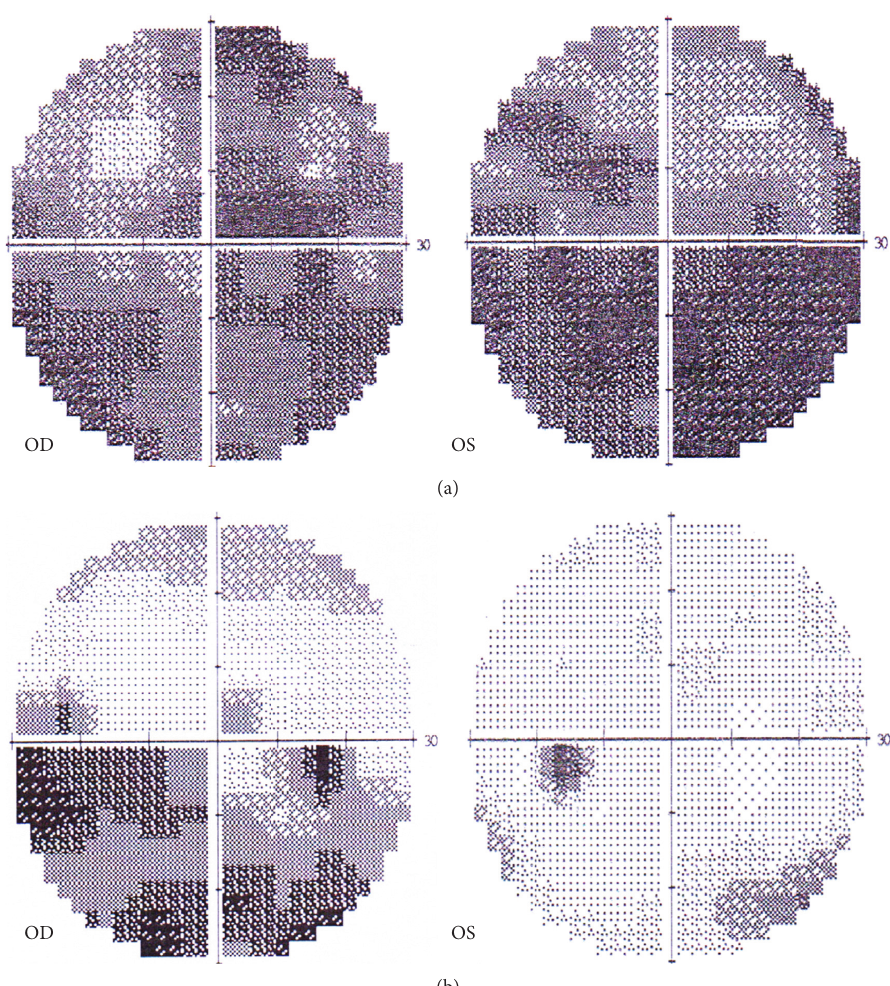
Figure 2: Grayscale showed visual field defect before and after orbital decompression on the left eye combined with methylprednisolone pulse therapy (MPT). (a) Severe visual field defect was shown in both eyes before orbital decompression on the left eye combined with MPT. (b) Visual field defect relieved in both eyes after orbital decompression on the left eye combined with MPT (the improvement in the operated eye was more significant than that of the fellow